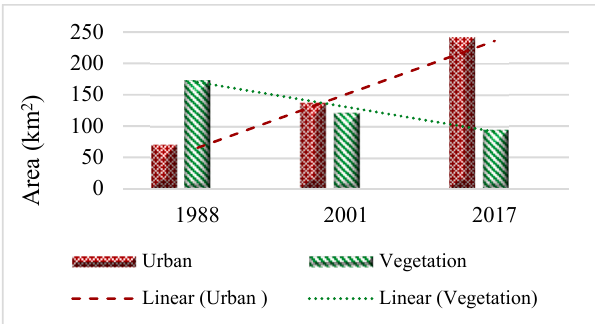
Figure 3. Urban land and vegetation cover in 1988, 2001 and 2017.